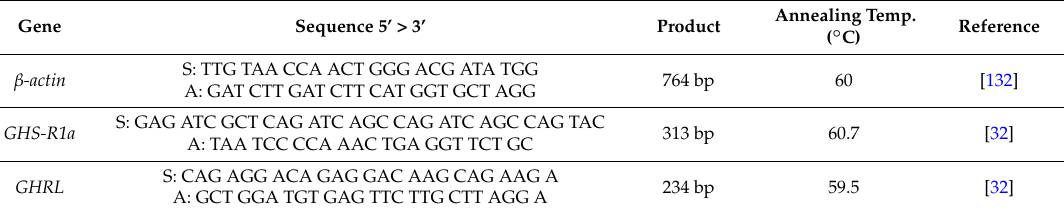
Table 1. Gene, primers’ sequences, product length, annealing temperatures,